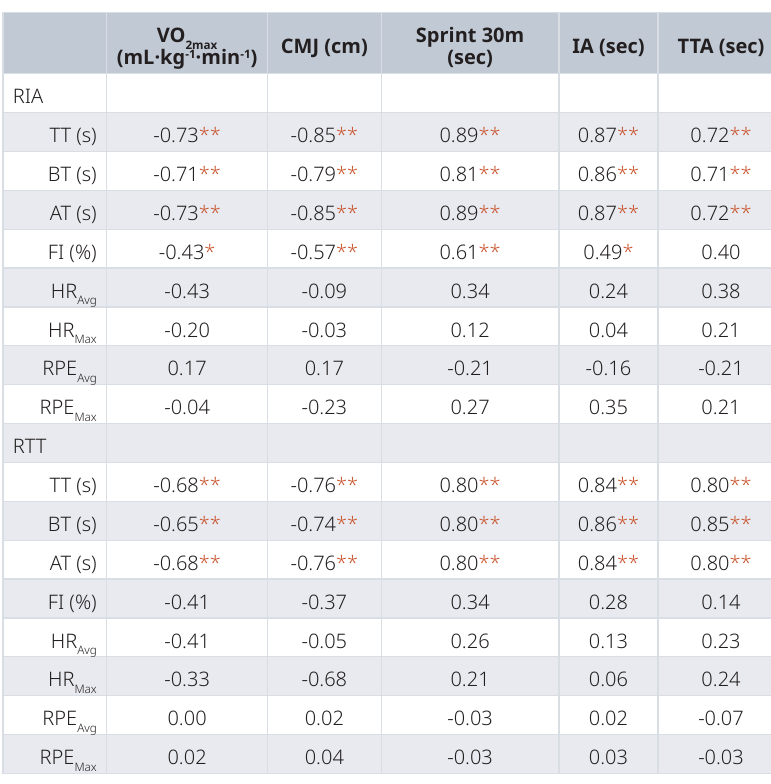
Table 2. Pearson correlation coefficients between repeated performances, perceptual and physiological indices (repeated Illinois agility [RIA], repeated T-agility test [RTT]) with aerobic capacity, leg power, speed, and agility test performance measures.